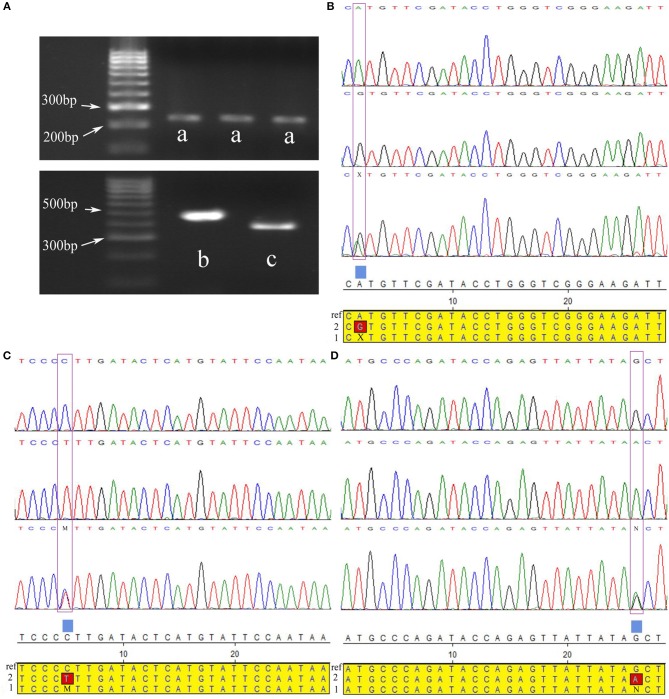
Three significant SNPs were validated for population genetics using direct sequencing in Chinese Holstein cows. (A) Gel electrophoresis pattern PCR amplified fragments near three significant SNPs, a-c were PCR amplified fragments of SNPs rs88640083, rs75762330, and rs20438858 regions, respectively. (B–D) Directing sequencing results of PCR amplification products near above three important SNPs, and their alignment with reference sequences (ref: reference sequences; 1: heterozygous sequences; 2: variant sequences). The purple boxes were where the three SNPs located. X, M, and N represented the heterozygous types of the three SNPs, respectively.